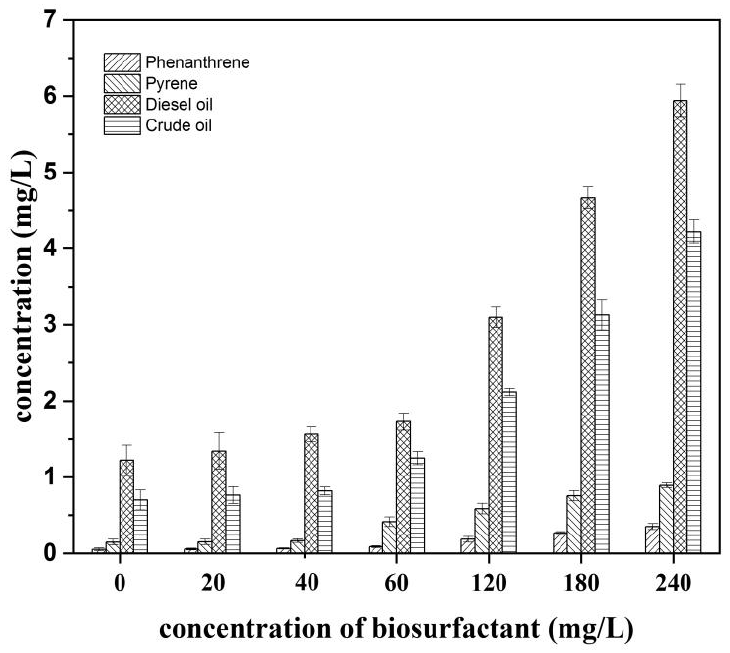
Figure 1. Effects of biosurfactant on the solubilization of Phen, Pyr, diesel oil and crude oil in aqueous phase.